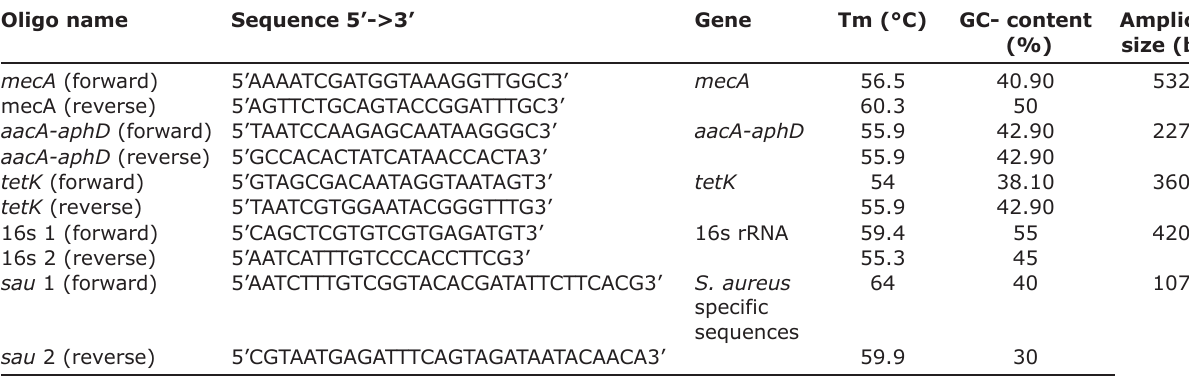
Table-1: Details of primers used in the present study.